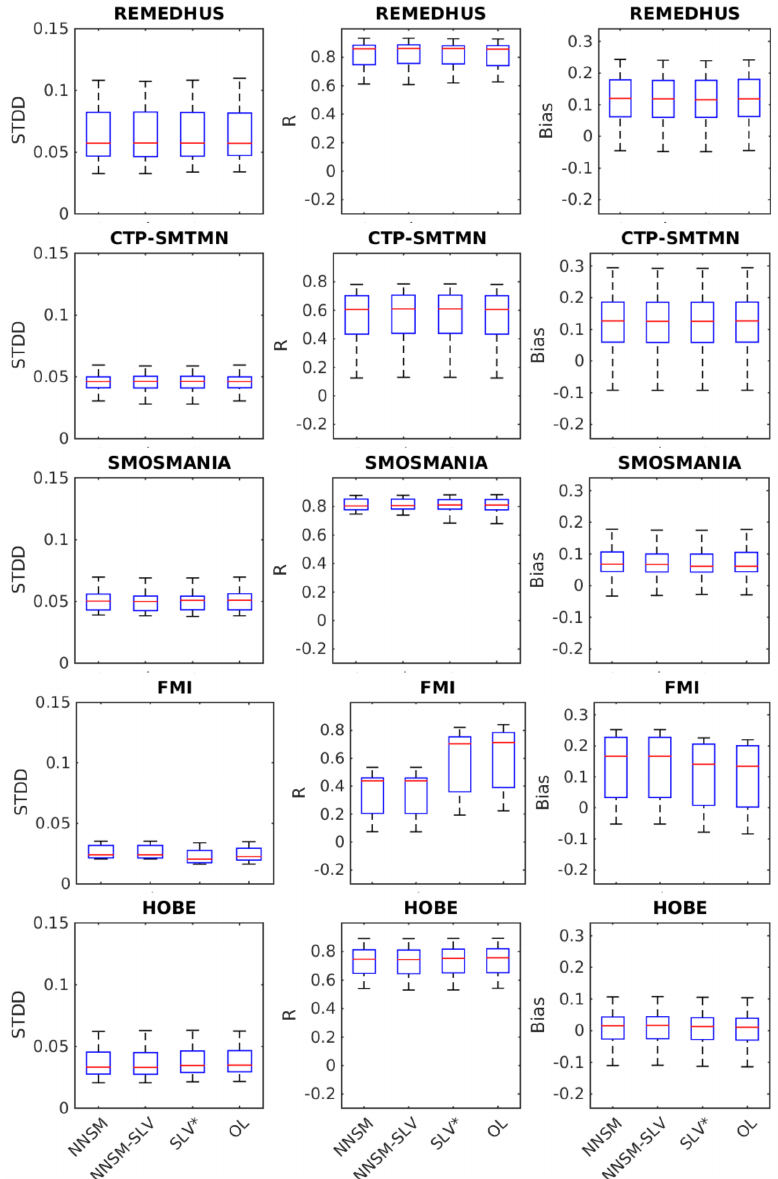
Figure 7. Box plots for the STDD, the Pearson correlation R, and the bias of different experiments with respect to in situ measurements network by network. On each box, the central mark indicates the median, and the bottom and top edges of the box indicate the 25th ( q 25 ) and 75th ( q 75 ) percentiles, respectively. Points are considered as outliers if they are greater than q 75 + 1.5 × ( q 75 − q 25 ) or less than q 25 − 1.5 × ( q 75 − q 25 ) . The whiskers extend to the most extreme data points not considered